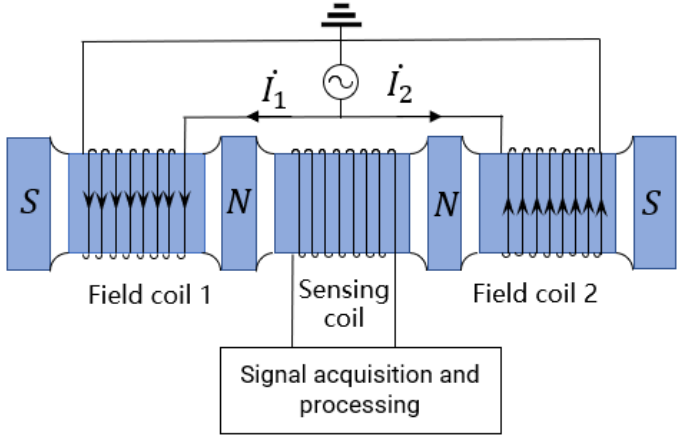
Figure 1. Schematic of detection. Sinusoidal alternating currents